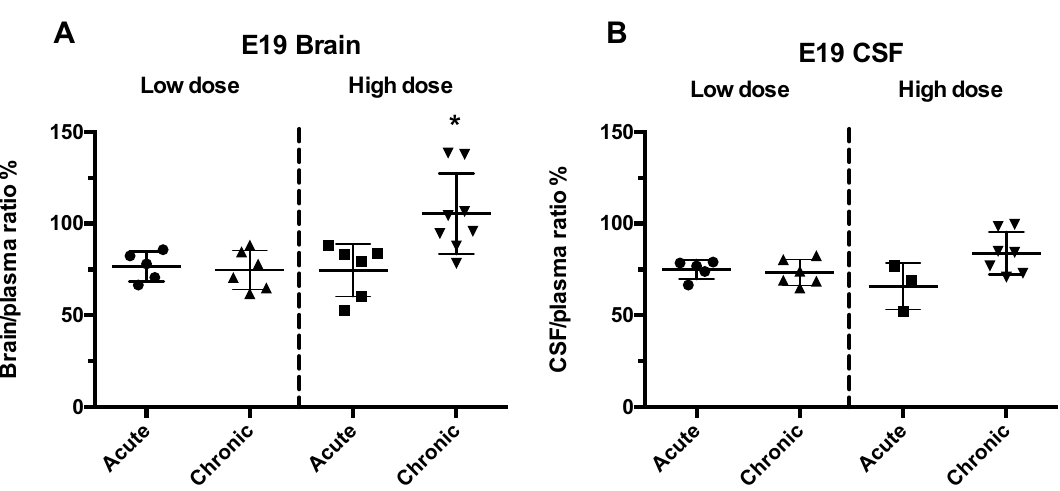
Figure 5. Entry of 3 H-paracetamol into fetal brain and CSF at E19 following low and high doses administered acutely or chronically. Results are expressed as brain/plasma and CSF/plasma ratios (%). The ratios were similar for brain and CSF. The chronic high dose brain mean was significantly higher than the other treatment groups. Horizontal bars are mean ± SD. Symbols are results from individual animals, *p < 0.05 for difference between high dose and all other treatments. High dose data from 2